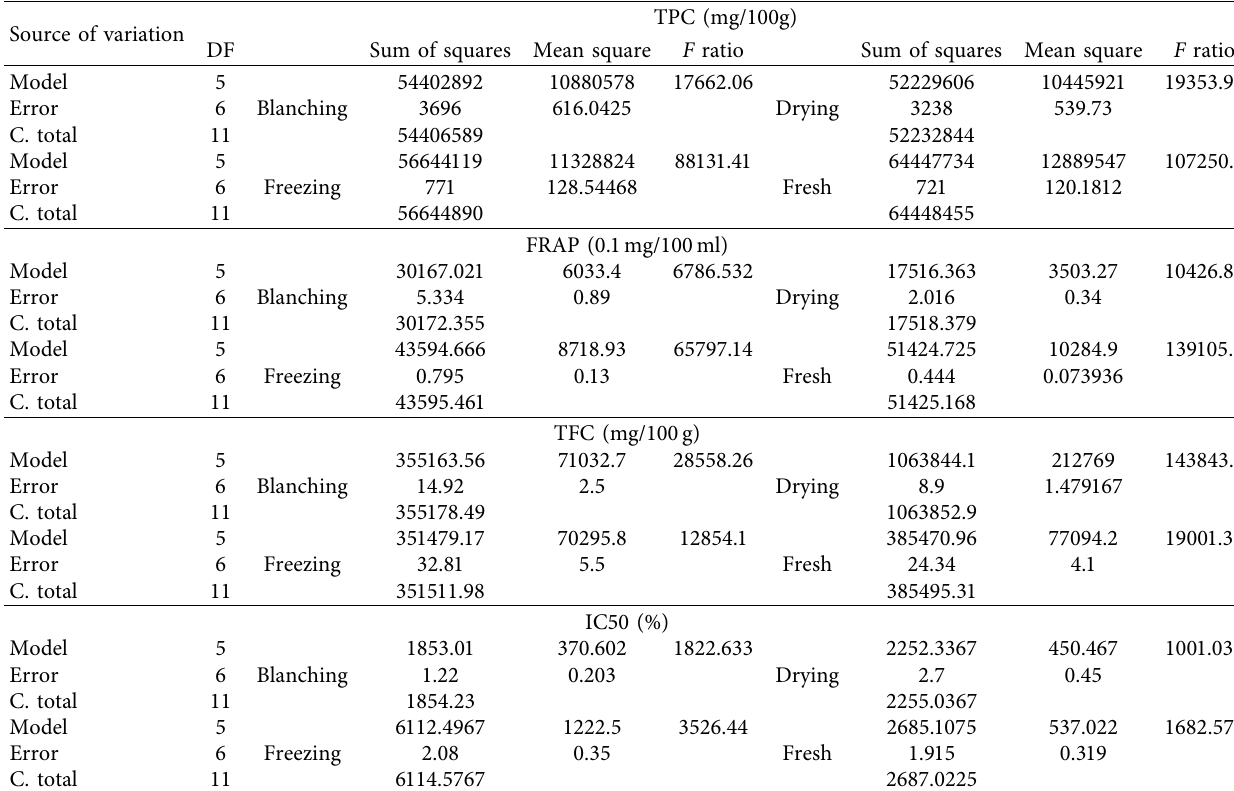
Table 3: Analysis of variance (ANOVA) of the total phenolic content (TPC), FRAP, total flavonoid content (TFC), and IC50 of fruit by- products during blanching, drying, fresh, and freezing. Source of variation